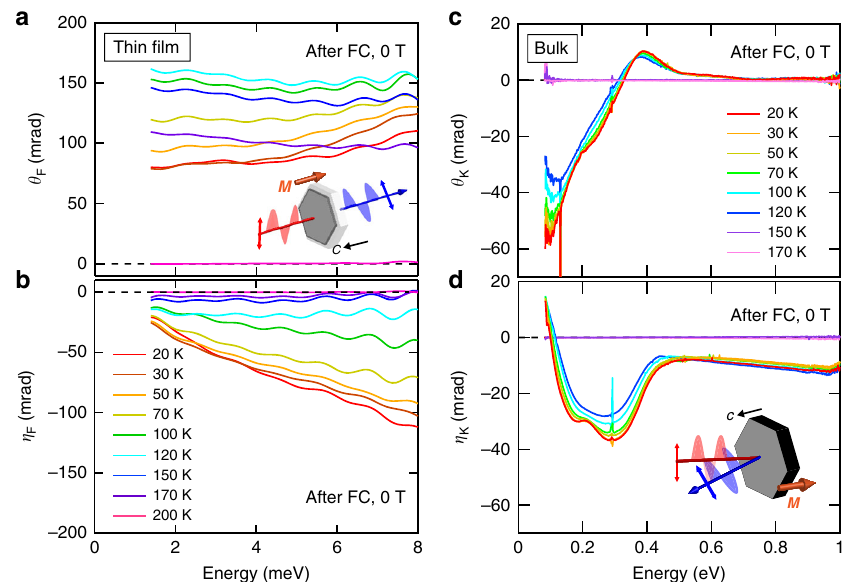
Fig. 2 Terahertz Faraday and infrared Kerr rotations. a Terahertz Faraday rotation ( θ F ) spectra. Inset: the schematic illustration of the Faraday rotation measurement. b Faraday ellipticity ( η F ) spectra. c Infrared Kerr rotation ( θ K ) spectra. d Infrared Kerr ellipticity ( η K ) spectra. Inset: the schematic illustration of the Kerr rotation measurement. The measurements were done after the fi eld cooling from 200